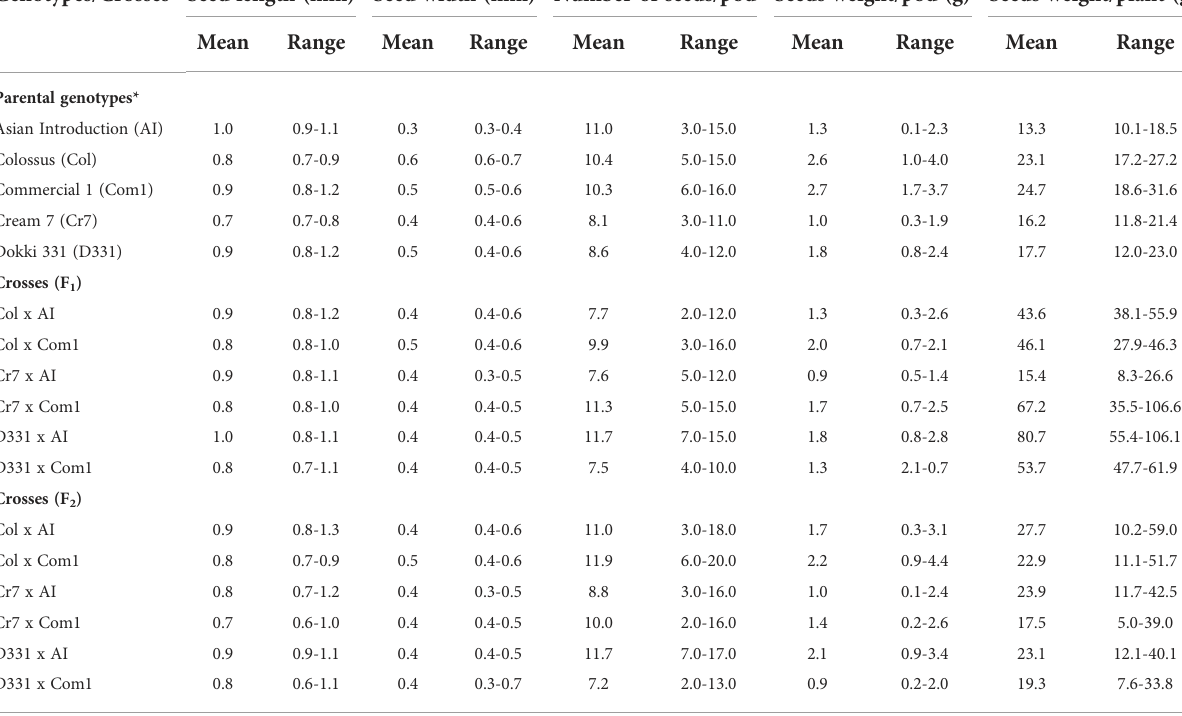
TABLE 4 Mean and range of seed length (mm), seed width (mm), number of seeds/pod, seeds weight/pod (g) and seeds weight/plant (g) of six cowpea crosses of F 1 , F 2 generations which produced from fi ve different